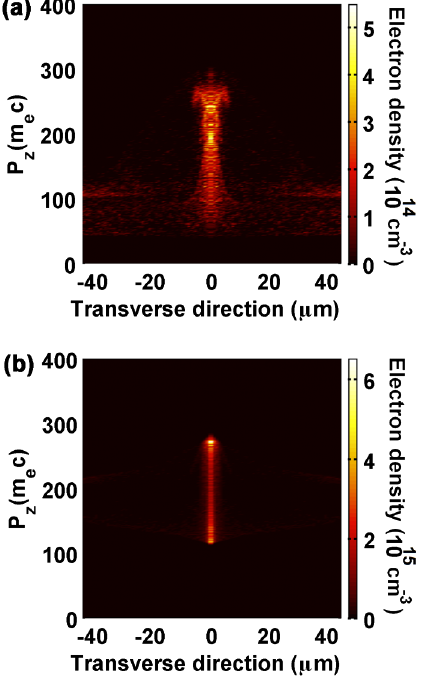
FIG. 4. Transverse position-longitudinal momentum phase space of the beam electrons after 9 mm acceleration for a ¼ 3 : 5 (cid:4) 10 16 cm (cid:1) 3 , (a) a ¼ 0 : 25 and (cid:1) ¼ beam density n 0 0 b ¼ 0 : 1 and (cid:1) ¼ 200 100 , and (b) a 0 0